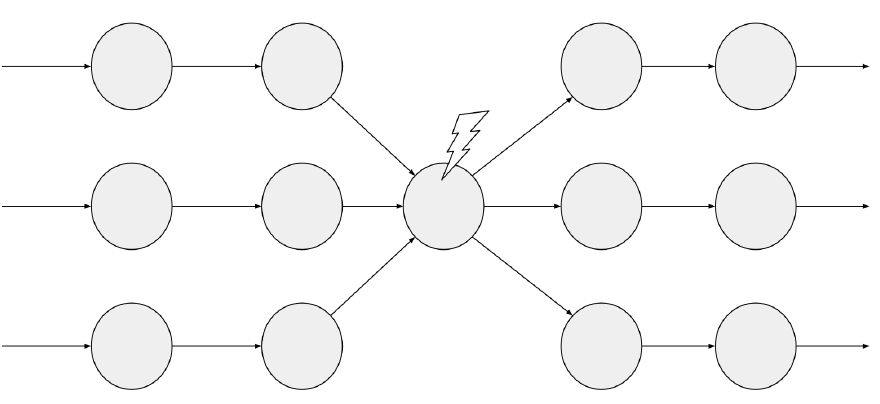
Figure 2. Single Point of Failure introduced inside a redundant domain by premature